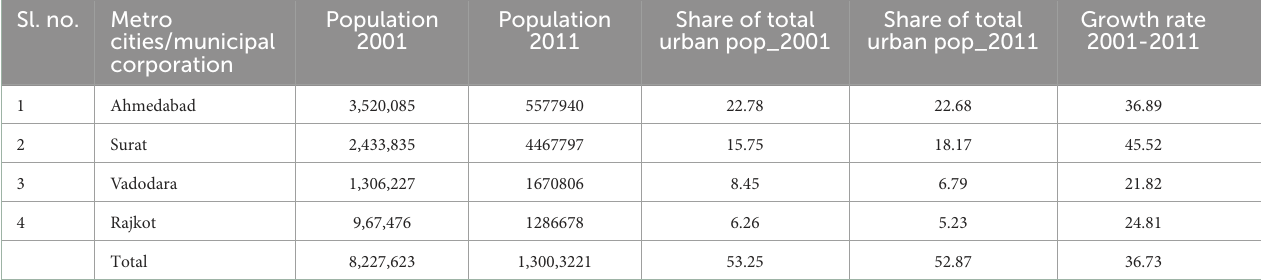
TABLE 6 Share and the rate of growth of urban population in metropolitan cities, Gujarat-2001-2011. Sl. no.